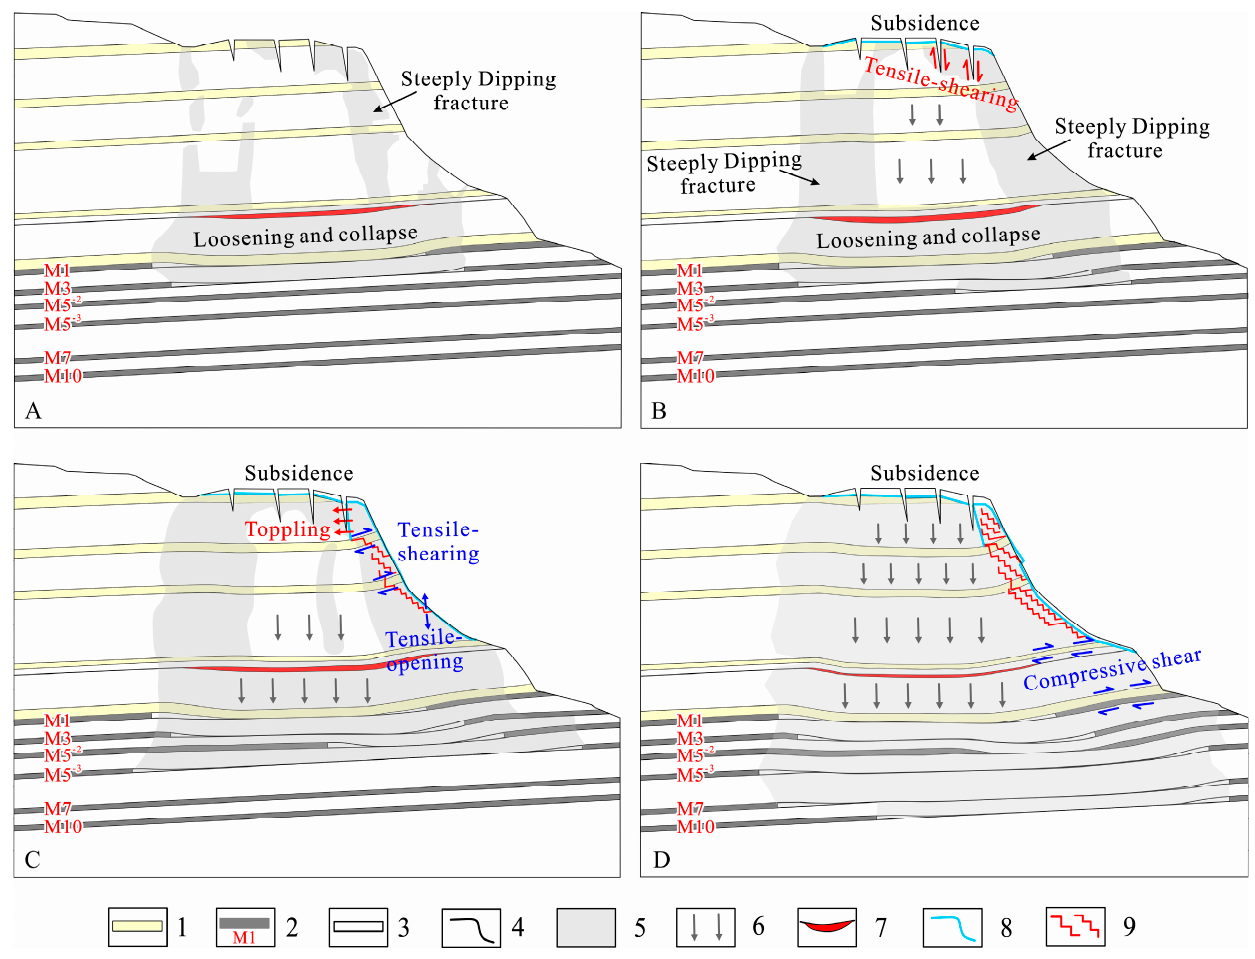
Figure 24. Schematic diagram of the evolution of the landslide: ( A ) mining stages I − IV; ( B ) mining stages I − VI; ( C ) mining stages I − VIII; and ( D ) mining stages I − XII. (1. mudstone; 2. coal seam and number; 3. goaf; 4. initial terrain line; 5. fractured and damaged zone; 6. uneven subsidence; 7. separation fracture; 8. terrain line after landslide; 9. multi-level stepped slip surfaces).